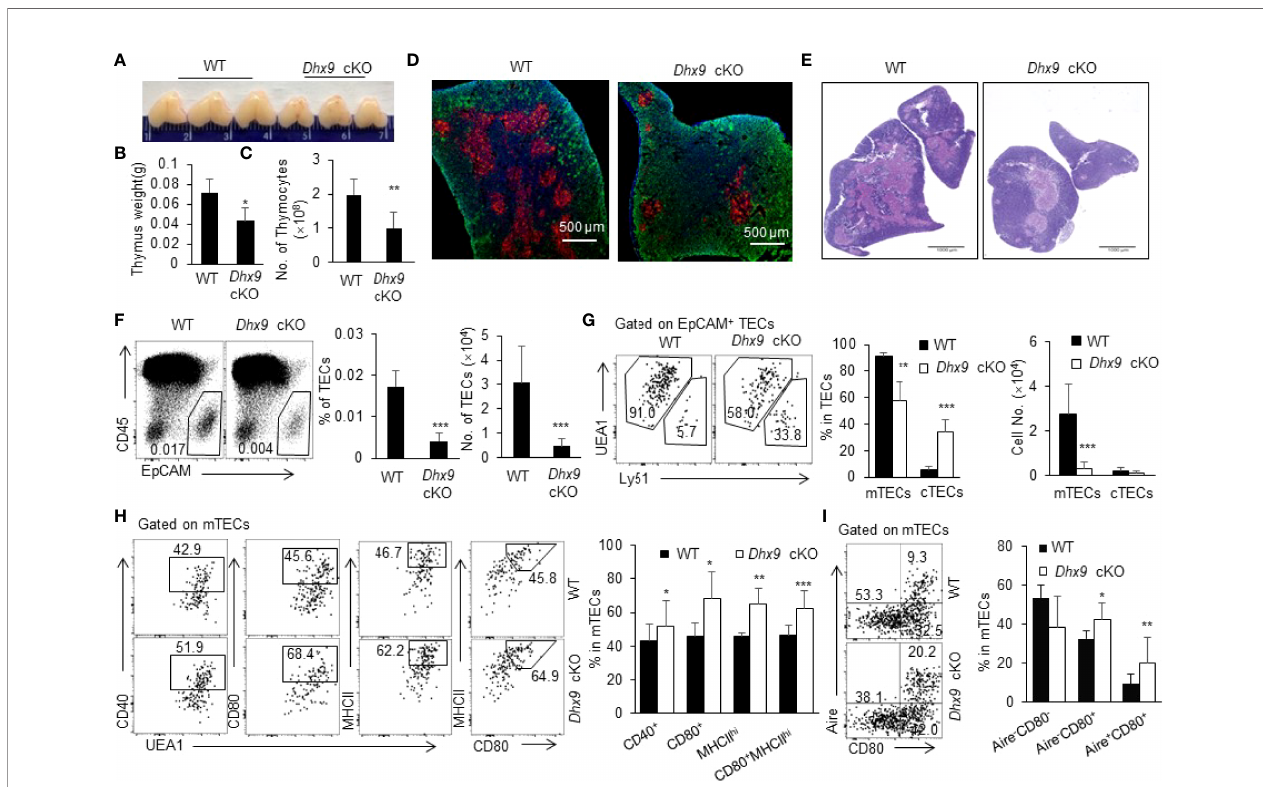
FIGURE 1 | Deletion of Dhx9 in TECs compromised the development and maturation of TECs. (A – C) The representative pictures (A) , weight (B) and cell numbers (C) of the thymus isolated from 4-week-old WT and Dhx9 cKO mice ( n = 10 for each group). (D) Immuno fl uorescence staining of frozen thymic sections of WT and Dhx9 cKO mice. Red: KRT5-marked medullary regions; Green: KRT8-marked cortical regions; Scale bars: 500 m m. (E) The representative thymic H&E staining in 4- week-old WT and Dhx9 cKO mice; Scale bars: 1000 m m. (F) Flow cytometric pro fi les, frequencies, and cell numbers of CD45 - EpCAM + TECs in 4-week-old WT and Dhx9 cKO mice ( n = 7 for each group). (G) Representative fl ow cytometry plots, frequencies, and cell numbers of UEA1 + Ly51 - mTECs and UEA1 - Ly51 + cTECs in 4- week-old WT ( n = 7) and Dhx9 cKO mice ( n = 6). (H) Representative fl ow cytometry plots and frequencies showed the maturation of mTECs, as measured by the expression of CD40, CD80, and MHCII in 4-week-old WT ( n = 8) and Dhx9 cKO mice ( n = 6). (I) Representative fl ow cytometry plots and frequencies exhibited the maturation stage by the expression of CD80 and Aire in 4-week-old WT ( n = 8) and Dhx9 cKO mice ( n = 6). One representative histogram represented the mean ± SD. The unpaired, two-tailed student ’ s t -test was used. * P < 0.05, ** P < 0.01, *** P < 0.001 compared with WT control